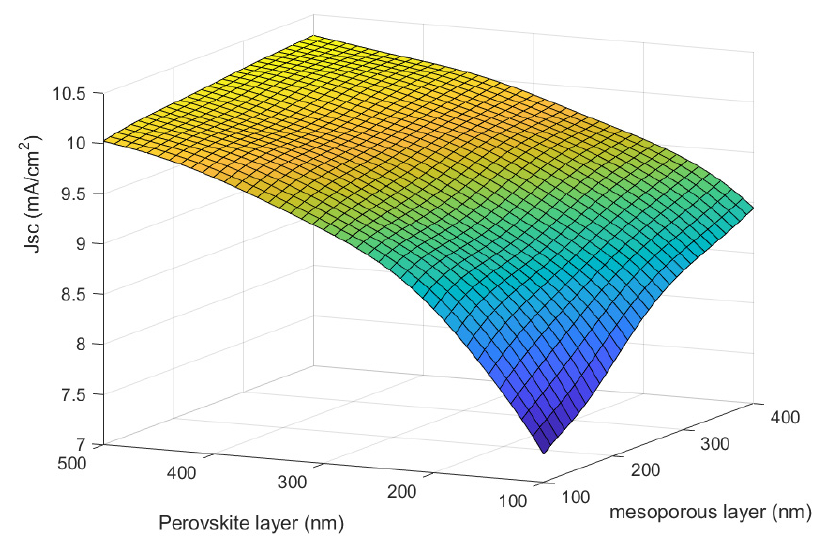
Figure 9. J SC of the fibre structure for varying perovskite and mesoporous layer thicknesses. In order to obtain better insight into the optical efficiency of the device, the normalized intensity of the electric field had to be examined. In Figure 10, the field intensity developed in the stack, for θ = 0, versus the wavelength is depicted, while on the left side, the relative thickness of the thin-film layers is shown. Only a planar segment of the structure was considered to allow a comparison with the one in Figure 5 to be conducted.